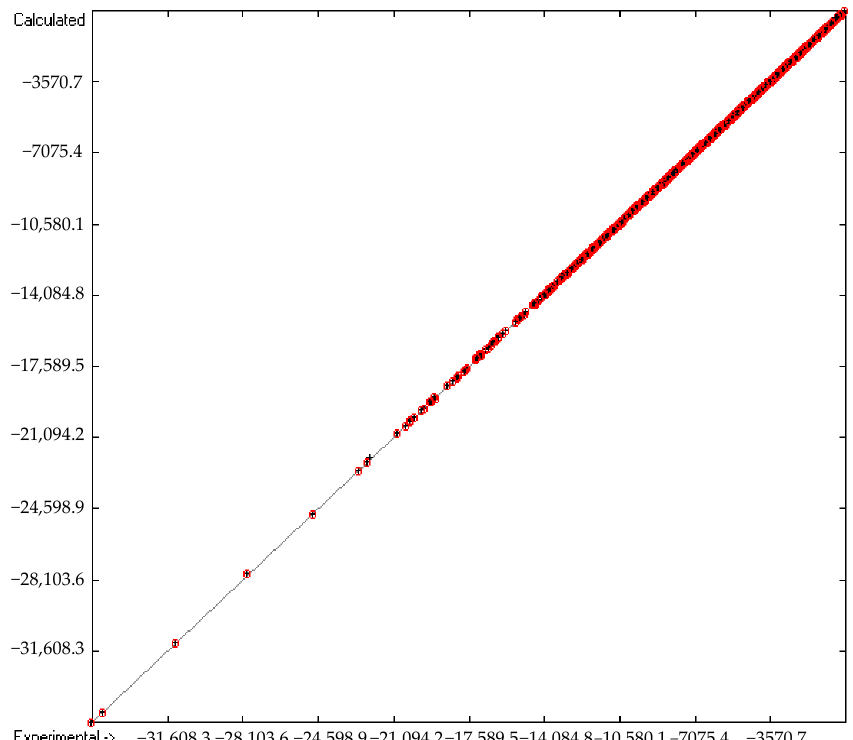
Figure 1. Correlation diagram of the heat-of-combustion data in kJ/mol. Cross-validation data are added as red circles. (10-fold cross-validated: N = 4886, Q 2 = 1, regression line: intercept = − 1.0111; slope = 0.9998).